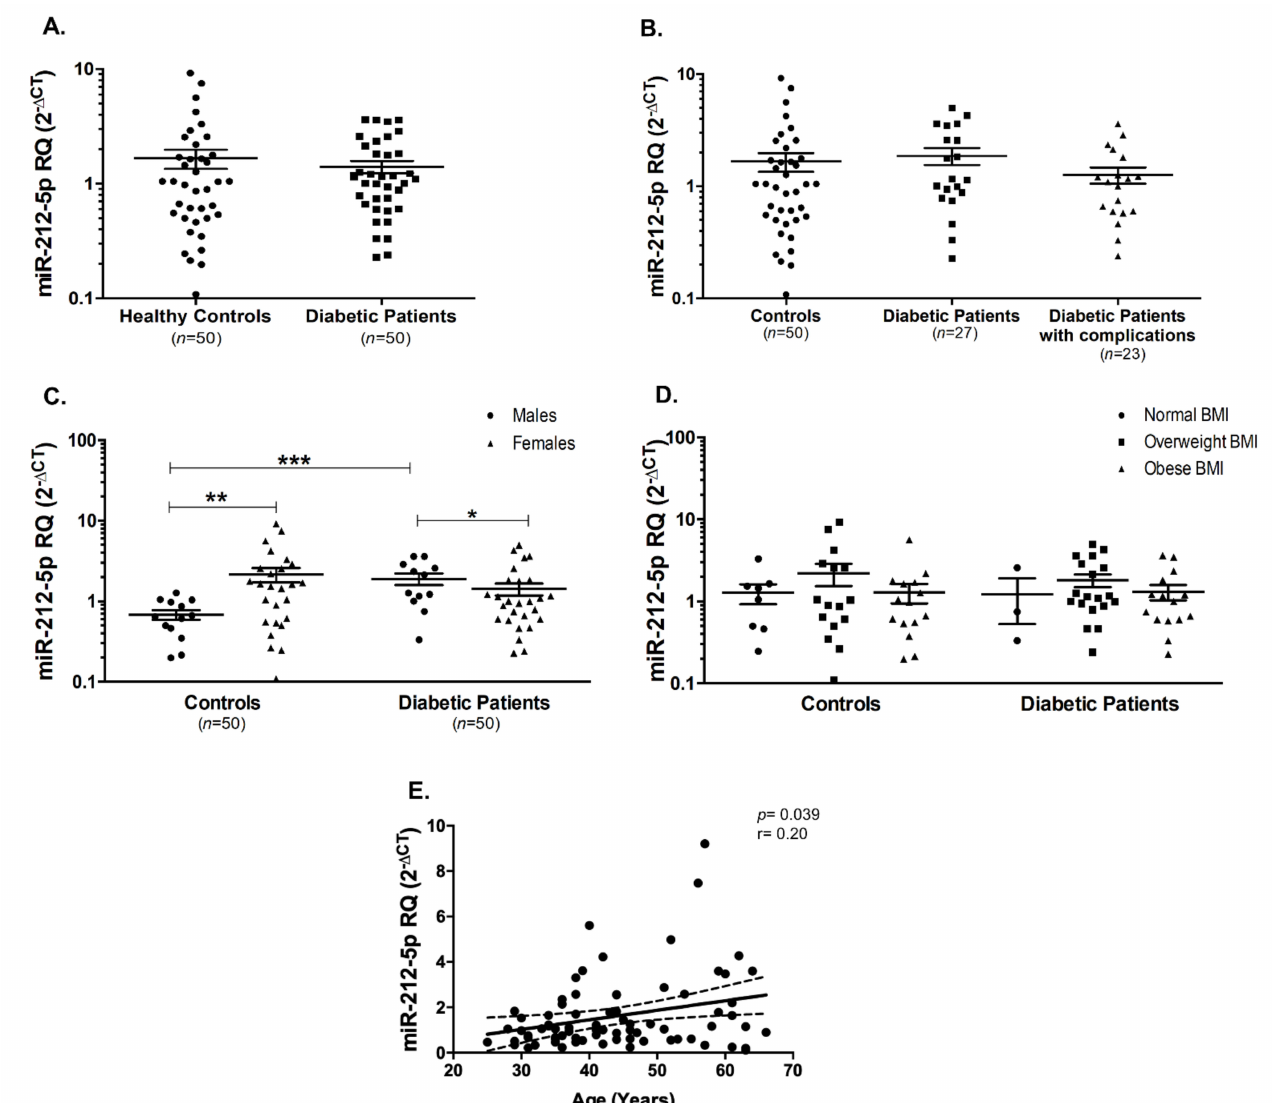
Figure 4. miR-212-5p was unaltered in T2DM patients compared to healthy controls. ( A ) miR-212-5p was not changed in all T2DM patients as well as ( B ) in diabetic patients with or without diabetic complications. ( C ) miR-212-5p levels were significantly altered by gender in healthy controls and diabetic patients. ( D ) miR-212-5p was unaffected in the different categories of healthy controls and diabetic patients depending on BMI. ( E ) There was a significant positive correlation between miR-212-5p and age. Dashed lines represent 95% confidence intervals. * p < 0.05, ** p < 0.01, and *** p <